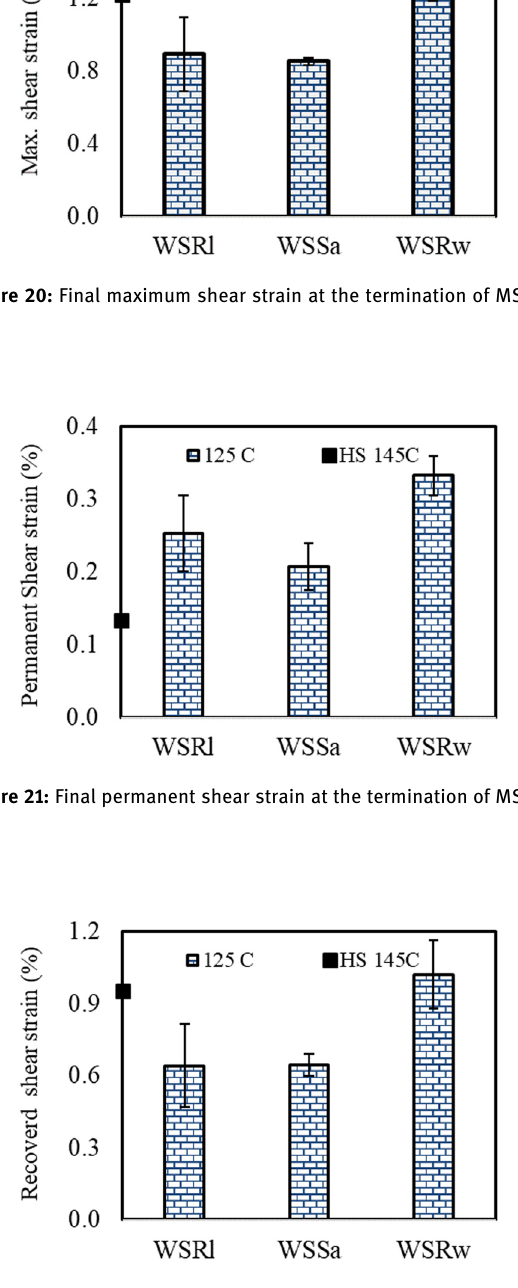
Figure 19: Recovered shear strain at each testing cycle of WMAs manufactured at 125°C.